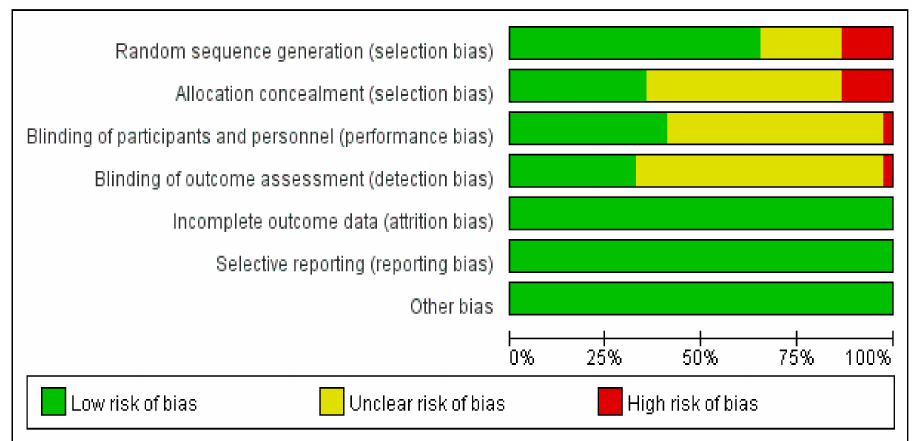
Figure 2. Risk-of-bias graph of systematic review on diagnostic tools and intervention methods for